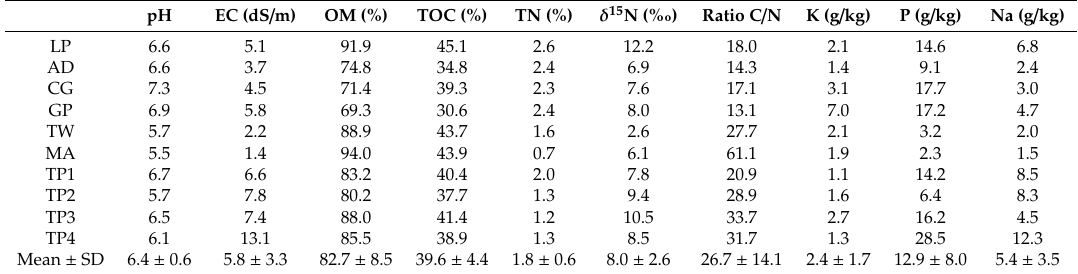
Table 3. Main physico-chemical and chemical characteristics of the bulking agents used in the composting mixtures (dry weight